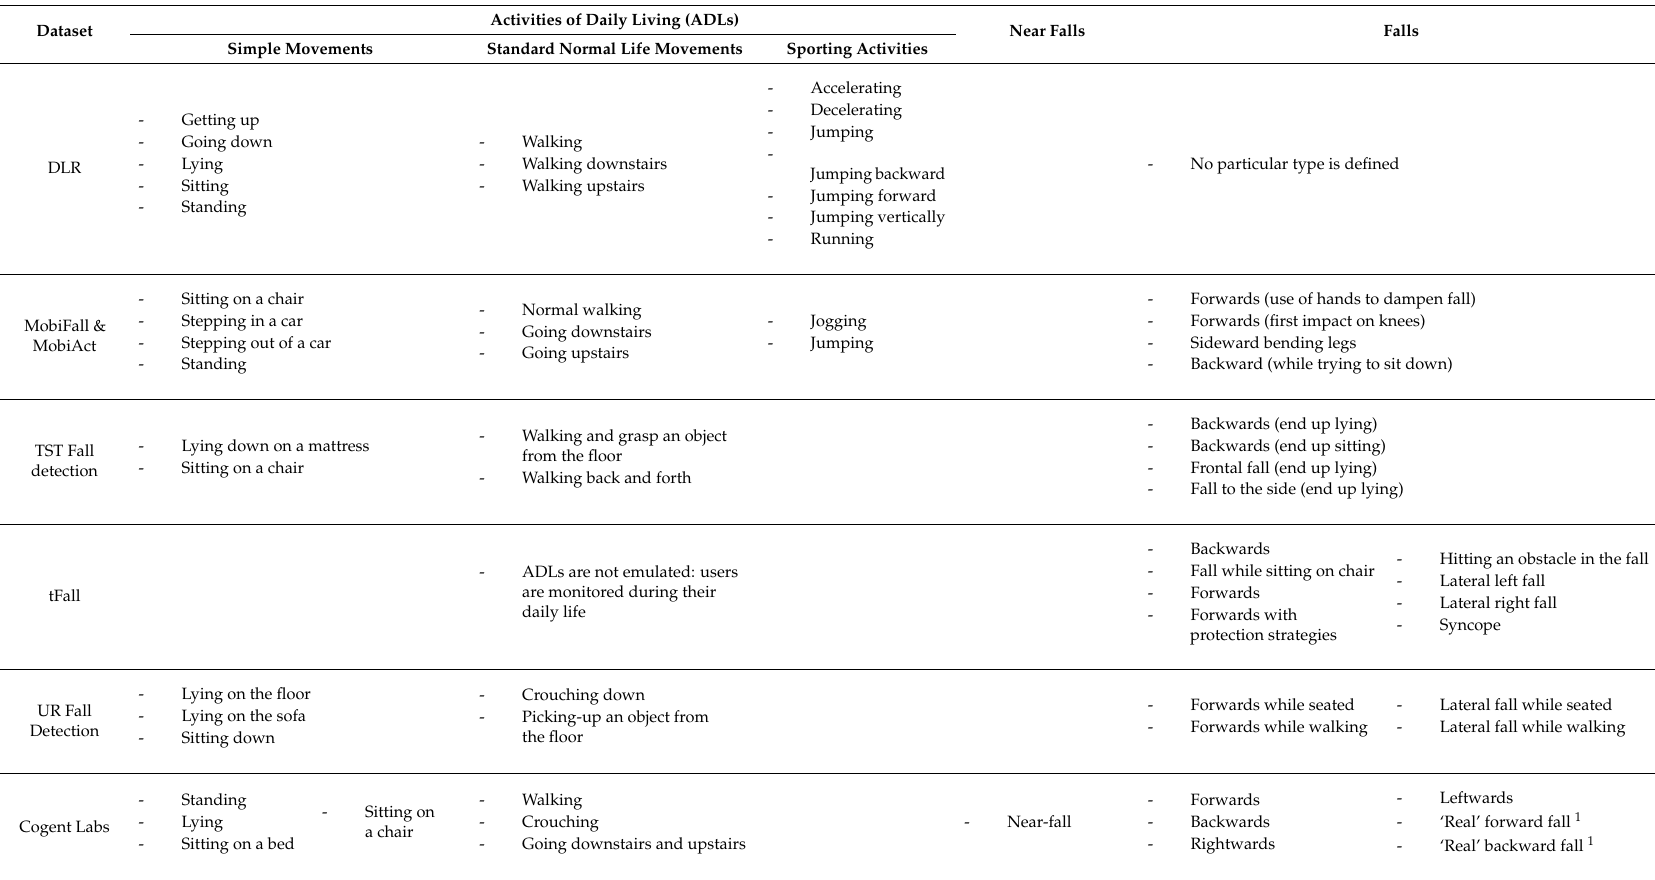
Table 6. Types of the activities (ADLs and falls) executed by the experimental